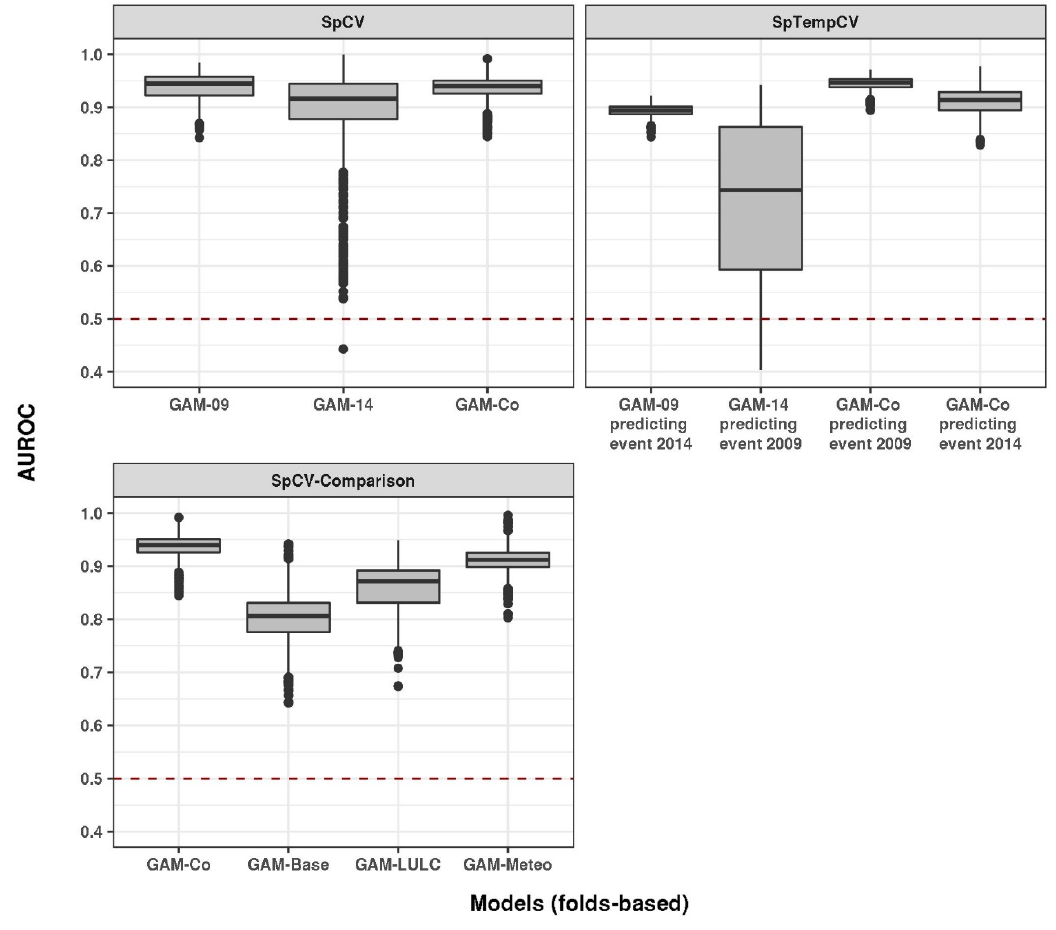
Figure 4. Model performance results. Boxplots show folds-based AUROC values using the validation data in the SpCV, SpTempCV and SpCV-Comparison model framework; Red dashed line: no discrimination.